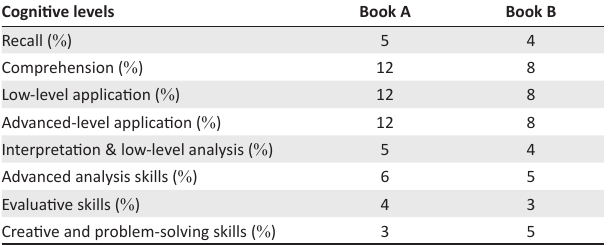
TABLE 5: Cognitive level and the percentage of assessment tasks per